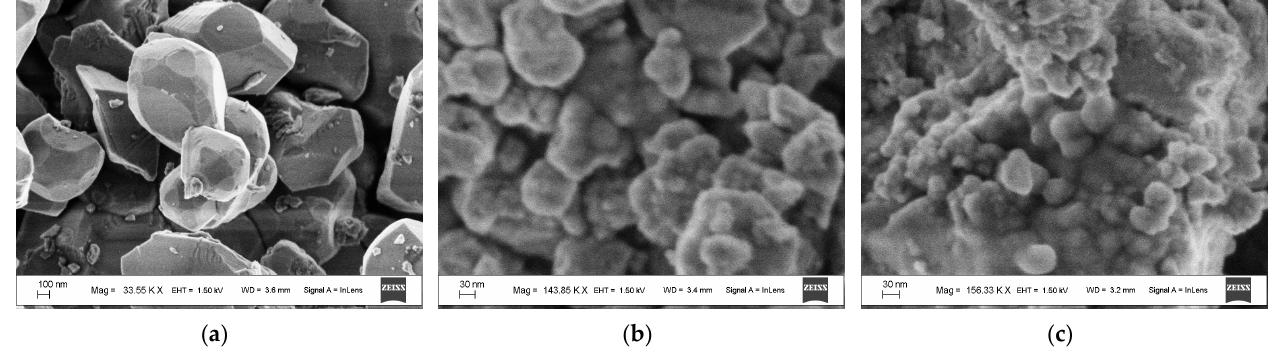
Figure 55. SEM images of NiFe 2 O 4 nanoparticles in samples N1 ( a ), N2 ( b ) and N3 ( c ). Adapted from Ref. [83] with permission from Springer Nature: Hyperfine Interactions, “The milling effect on nickel ferrite particles studied using magnetization measurements and Mössbauer spectrosco ‐ py”, Ushakov M.V., Oshtrakh M.I., Chukin A.V., Šepelák V., Felner I., Semionkin V.A., ©2018.